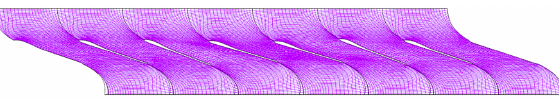
Figure 10. Simplified domain for TRAF computations.